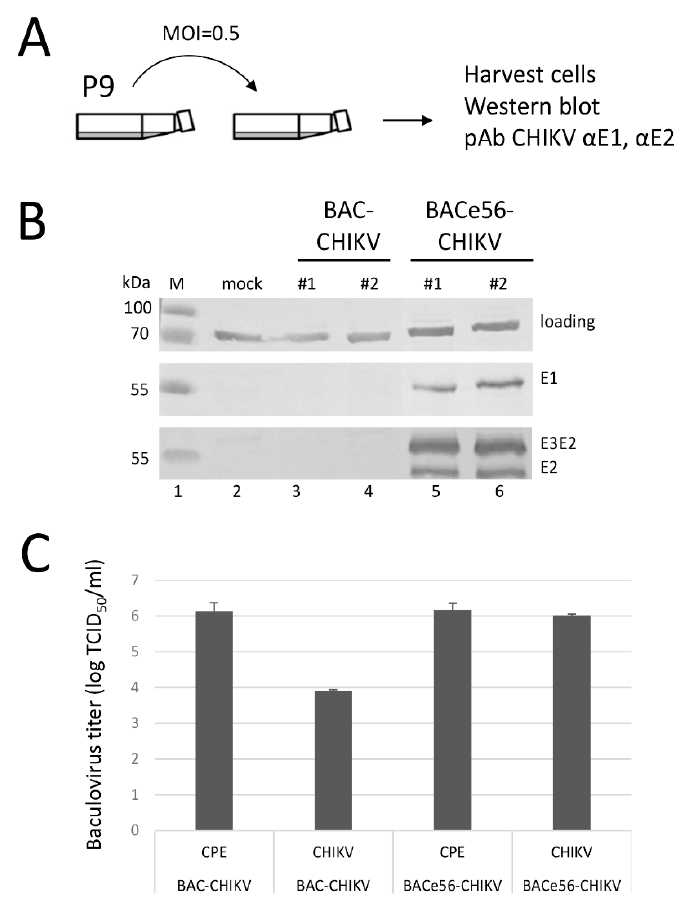
Figure 6. Stability of chikungunya VLP production with novel recombinant baculovirus BACe56. ( A ) Experimental set-up to determine VLP production after 10 duplicate passages. ( B ) Western blots detected with anti-E1 and anti E2 polyclonal antiserum show CHIKV glycoproteins E1, E2 and the precursor E3E2. #1 and #2 represent duplicate serial passage experiments. M: protein marker; loading: host cell protein; mock: healthy cells. ( C ) Titers of the recombinant baculovirus at passage 10. Viral titers were determined by end point dilution assay and are expressed as tissue culture infective doses 50% per ml (TCID 50 / mL ). Titers were scored on cytopathic e ff ect (CPE) or on reactivity with anti-E2 polyclonal antiserum